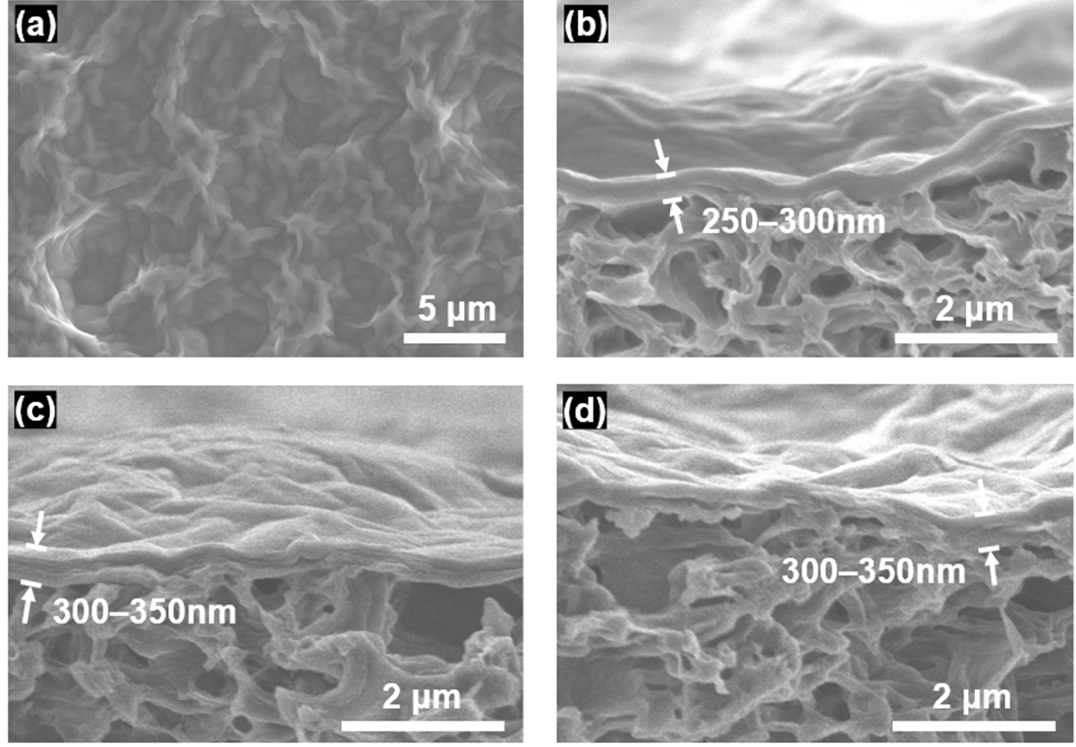
Figure 1. SEM images of ( a ) the surface of the pristine GO membrane and cross-sections of the ( b ) pristine GO, ( c ) GO/DCX RT, and ( d ) GO/DCX HT membranes.